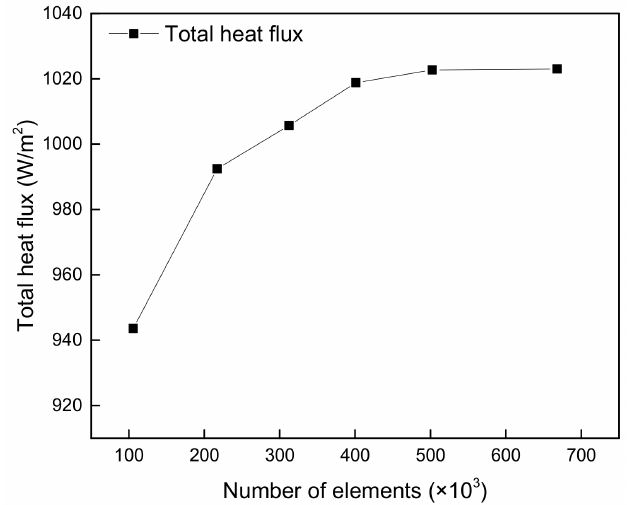
Figure 2. Grid dependency